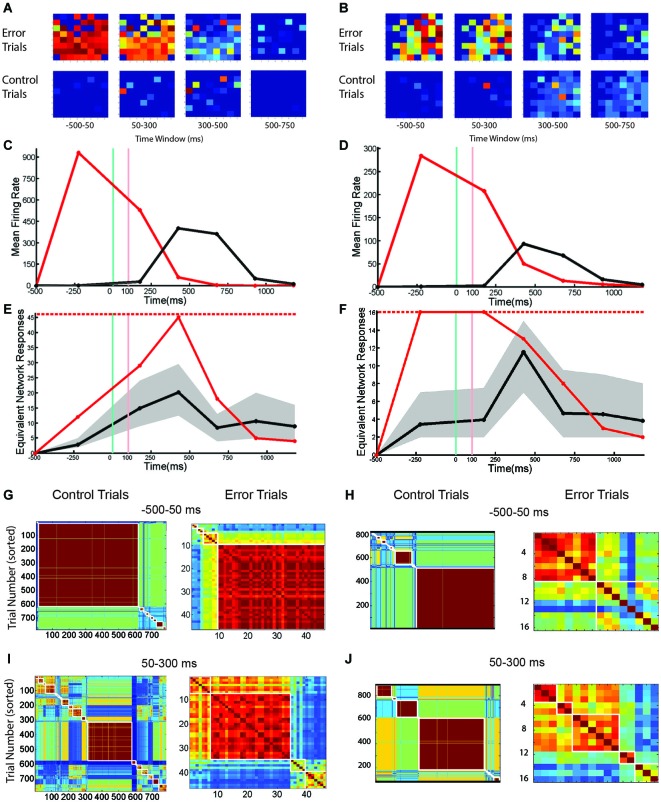
The Number and Pattern of Units Activated by a SNB is Network Specific. (A,B) Active units during trials with SNBs (top row) and control (bottom row) for two networks: Batch1905-Dishes 1, DIV9 and 4, DIV11 (left and right). Each 8 × 8 array is laid out in the same configuration as the recording electrodes. Color map indicates probability that a given unit is active in specified time bin. (C,D) Mean firing rate (spikes/s) during control (black) or trials with SNBs (red). (E,F) Entropy time series. The entropy during trials with SNBs (solid red line) measures how many unique network response patterns were seen in each time bin (y = axis counts the equivalent number of unique network response patterns associated with the entropy value, see Materials and Methods). The number of trials with SNBs is the upper limit on entropy (dashed red line; E: 46 trials with SNBs, F: 16 trials with SNBs). Solid black line indicates the average entropy for 46 control trials (E; sampled from 783 control trials, 46 trials with SNBs) or 16 control trials (F; sampled from 816 control trials, 16 with SNBs). Trials without SNBs were resampled 300 times and 99th percentiles are shown in gray. Other details as in legend of Figure 1. (G–J) Cross-correlation matrices computed at two time points for control (left) and trials with SNBs (right). Trials are sorted to form clusters of similar network responses (red squares). Each cell in the cluster compares the binary response vectors from the two trials as indicated by row and column position and the Color map indicates the correlation distance (response similarity) between the two binary network activity vectors (range = 0 to 1). (G,H) Network responses from the first time bin, prior to stimulus presentation, ranging −500 ms to 50 ms post-stimulus. (I,J) Network responses from the second time bin, during and after stimulus presentation, ranging from 50 to 300 ms post-stimulus.